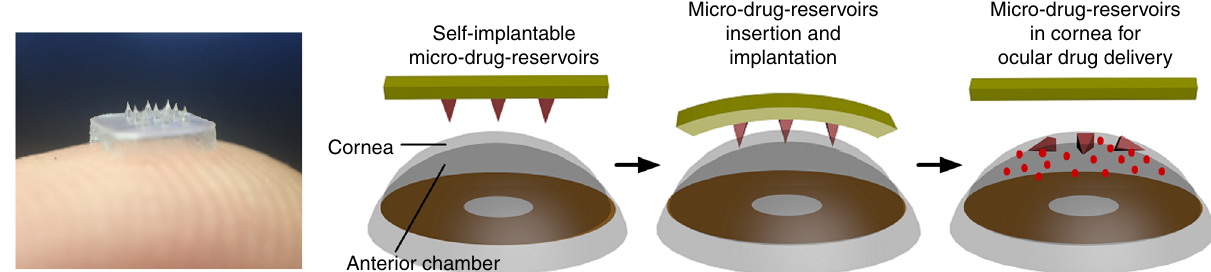
Fig. 1 Illustration of eye-contact patch for ocular drug delivery. The eye patch is equipped with an array of self-implantable